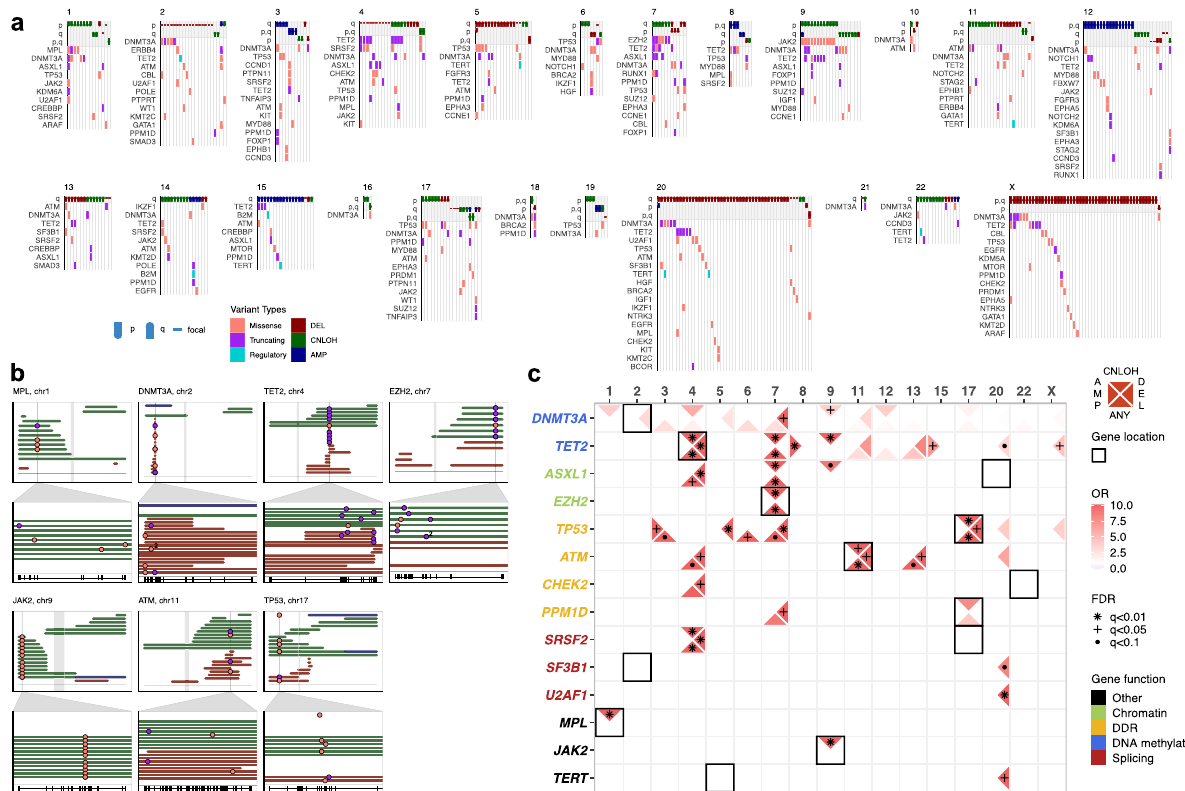
Fig. 3 Patterns of co-occurrence between mCAs and gene mutations reveal diverse mechanisms of selection. a mCA events and their co-occurring gene mutations. Events are colored by alteration types. Only genes that appear more than one time are shown. b Gene loci that exhibited recurrent double hits in cis . Zoom window shows the gene loci affected and the location of the gene mutations; “ 2 ” denotes two adjacent mutations in close proximity with each other. Centromere positions are marked in gray. Gene structures are displayed below. c Pairwise associations of co-mutations between speci fi c mCAs and gene mutations. Associations with speci fi c chromosomal alteration types are indicated by the position of the triangle (left: AMP, top: CNLOH, right: DEL, bottom: any). FDR-corrected signi fi cance values from pairwise Fisher ’ s exact tests are indicated by shapes of asterisks. Odds ratios are indicated by the transparency of red shading. The chromosomal location of genes are indicated by black squares. Gene labels are colored by functional groups. Source data are provided as a Source Data fi